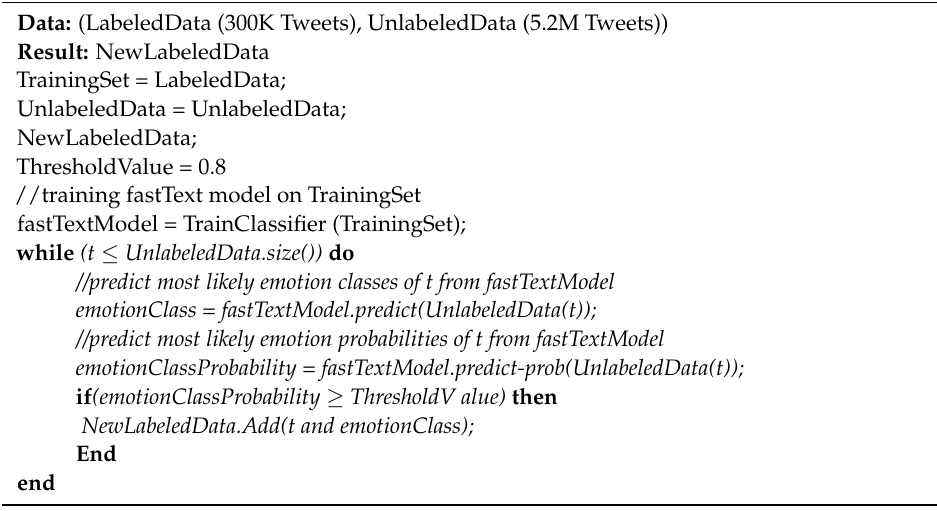
Figure 4. Automatic Emotion Annotation. Algorithm 1 Automatic Emotion Annotation Algorithm 1 Automatic Emotion Annotation Algorithm